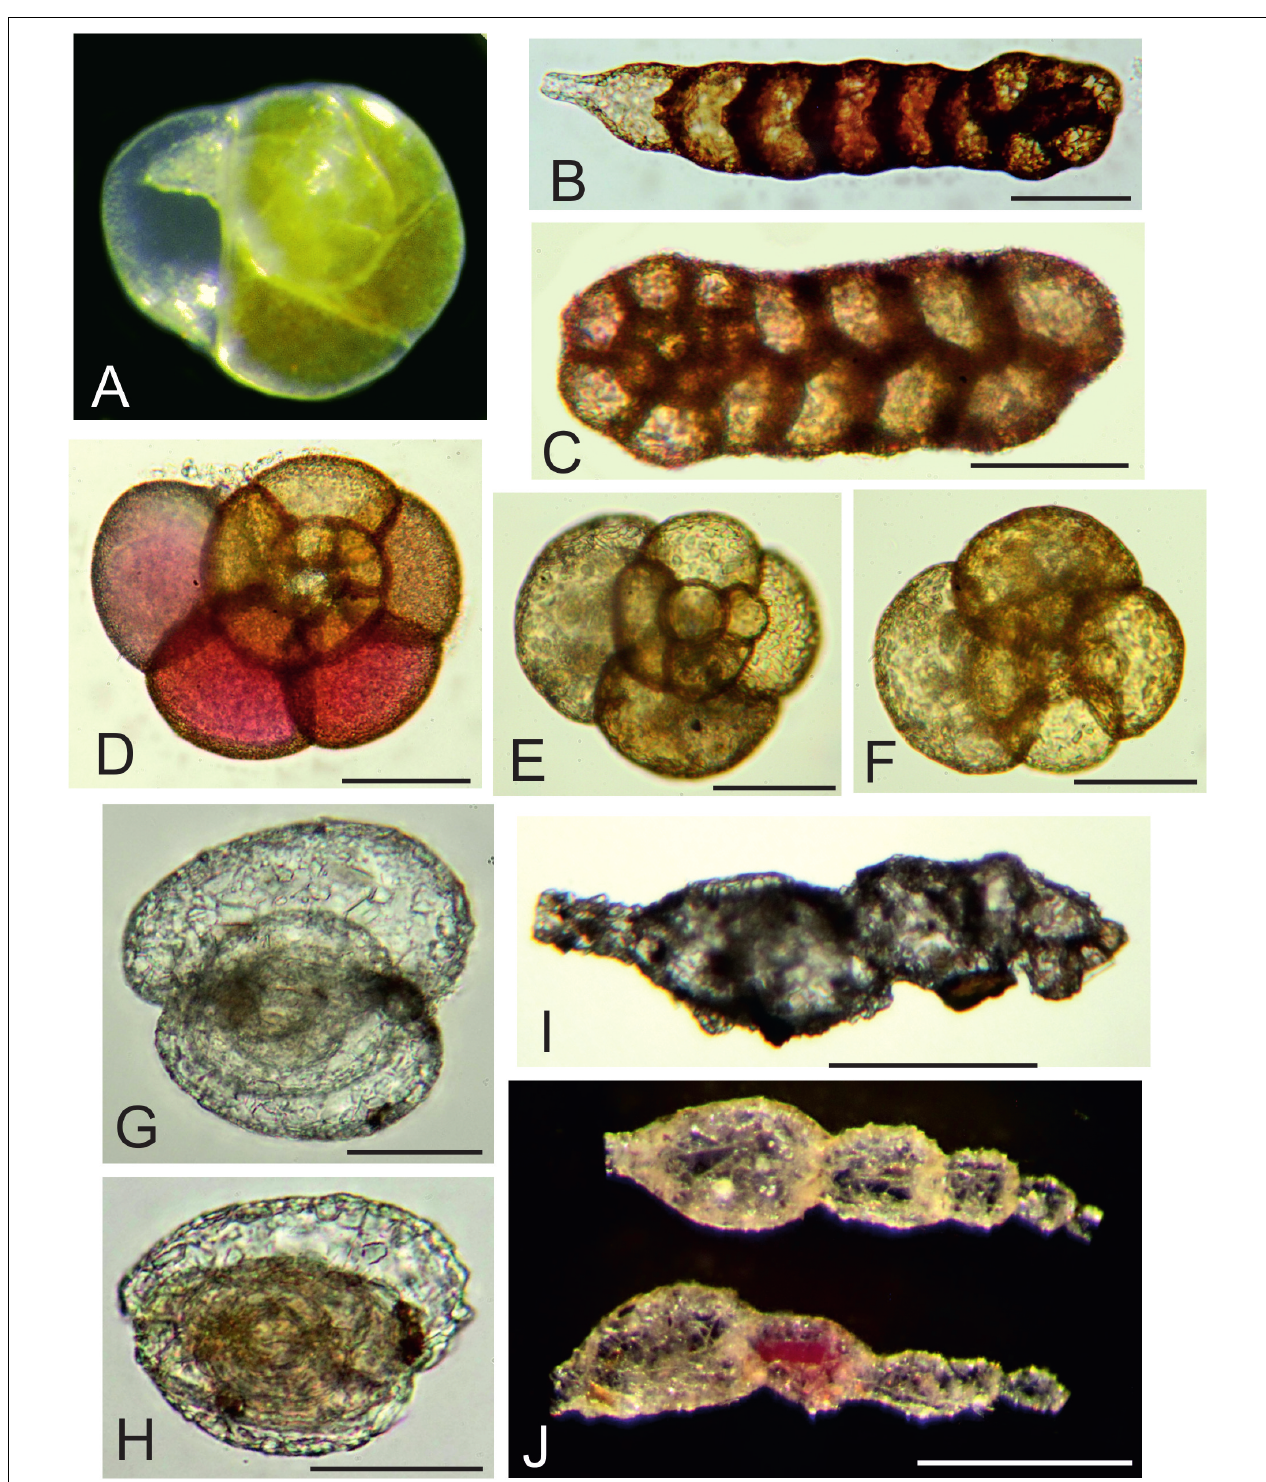
FIGURE 2 | Multichambered foraminifera. (A) Epistominella exigua Brady; ‘live’ specimen with green cytoplasm, picked from > 150 µ m residue at sea. (B) Ammobaculites filiformis Earland; MC09, 0–0.5 cm, 63–125 µ m fraction. (C) Spiroplectammina subcylindrica Earland; MC21 G 0–0.5 cm, 63–125 µ m. (D) Trochamminacean sp. 1; MC21, 0.5–1.0 cm, 63–125 µ m fraction. (E,F) Trochamminacean sp. 2; MC21, 0.5–1.0 cm, 63–125 µ m fraction. (G,H) Adercotryma sp.; MC21, 0.5–1.0 cm, 63–125 µ m fraction. (G) Rounded specimen. (H) More elongate specimen. (I) Reophax scorpiurus Montfort, MC11, 0.5–1.0 cm, 150–300 µ m fraction. (J) Reophax sp. 1, MC05, 0–0.5 cm, > 300 µ m fraction. Scale bars = 50 µ m (A–H) , 250 µ m (I) , 500 µ m (J)